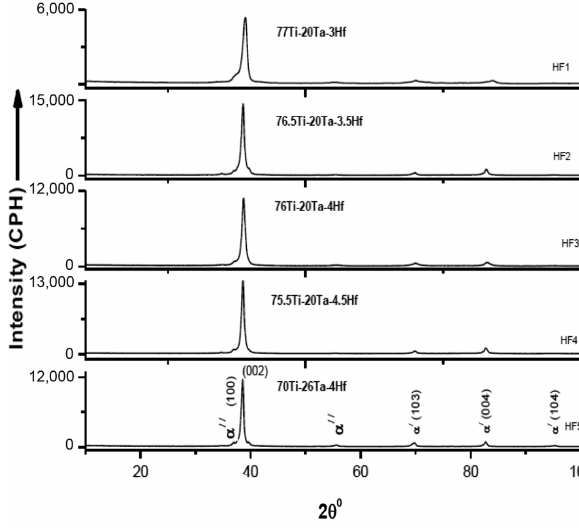
Figure 3: XRD profiles of Ti – 20Ta – xHf and 70Ti26Ta4Hf taken at room temperature, quenched in iced brine after solution treated at